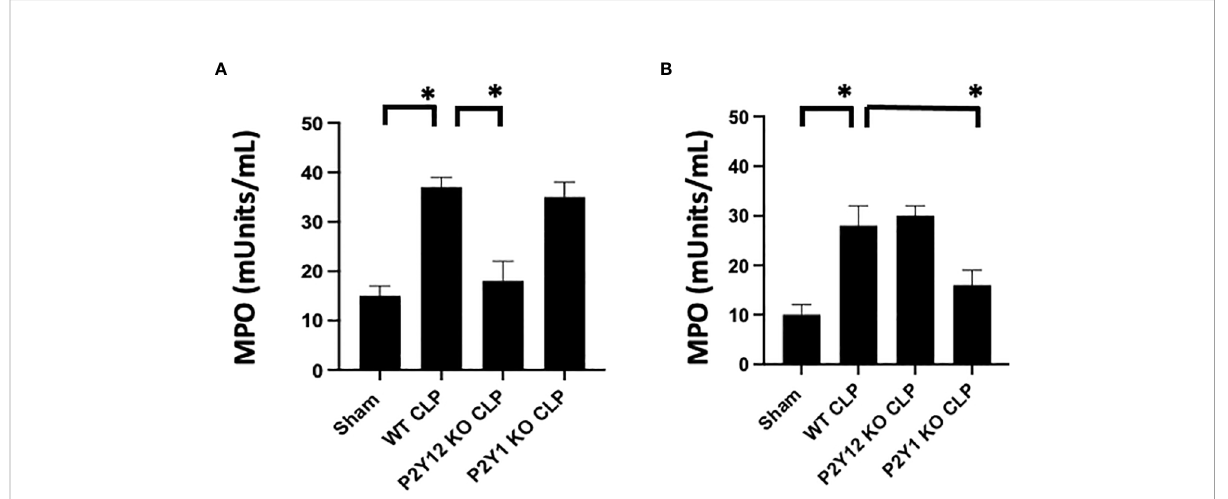
FIGURE 2 Sepsis-induced increase of activity of MPO in the lungs is reduced in male septic P2Y 12 and female septic P2Y 1 KO mice. MPO analysis was performed in lung samples of Sham and CLP in wild-type (WT) and P2Y 12 KO and P2Y 1 mice of male (A) and female (B) mice. Values are expressed as mUnits/mL, mean ± SEM. (*P < 0.05) (n = 5). No differences between WT, P2Y 12 KO, and P2Y 1 KO sham were noted in both male and female mice (data not